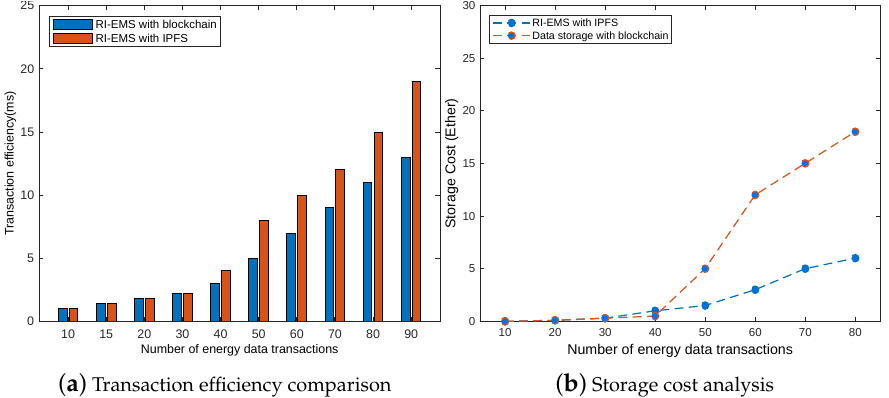
Figure 7. Comparative analysis: ( a ) Transaction efficiency comparison for the proposed RI-EMS approach, ( b ) Storage cost analysis for proposed RI-EMS